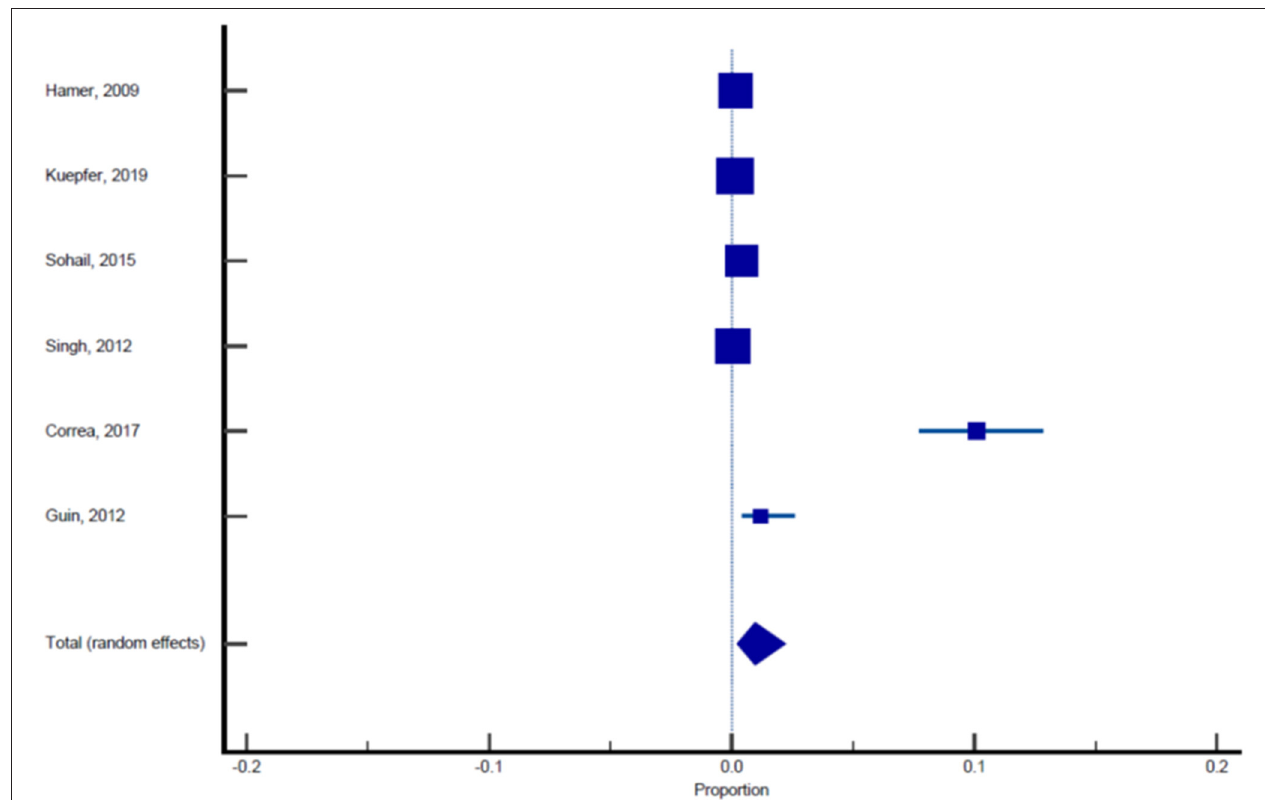
FIGURE 9 | Pooled estimates of the prevalence of mixed infection among pregnant women.